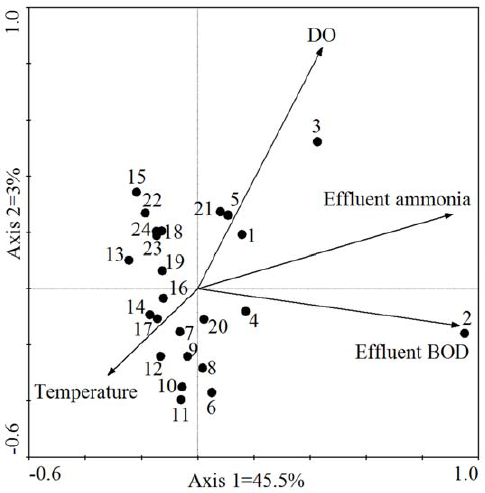
Figure 5. Canonical correspondence analysis (CCA) biplot based on T-RFLP data and measurable variables (operational and environmental) in the pilot-scale wastewater treatment plant. Arrows indicate the direction and magnitude of measurable variables associated with AOB community structures. Each Circle and associate number represents a different AOB community structure from a specific sampling date. Environmental variables were chosen based on significance ( P , 0.05) calculated from individual CCA results and variation inflation factors calculated during CCA.